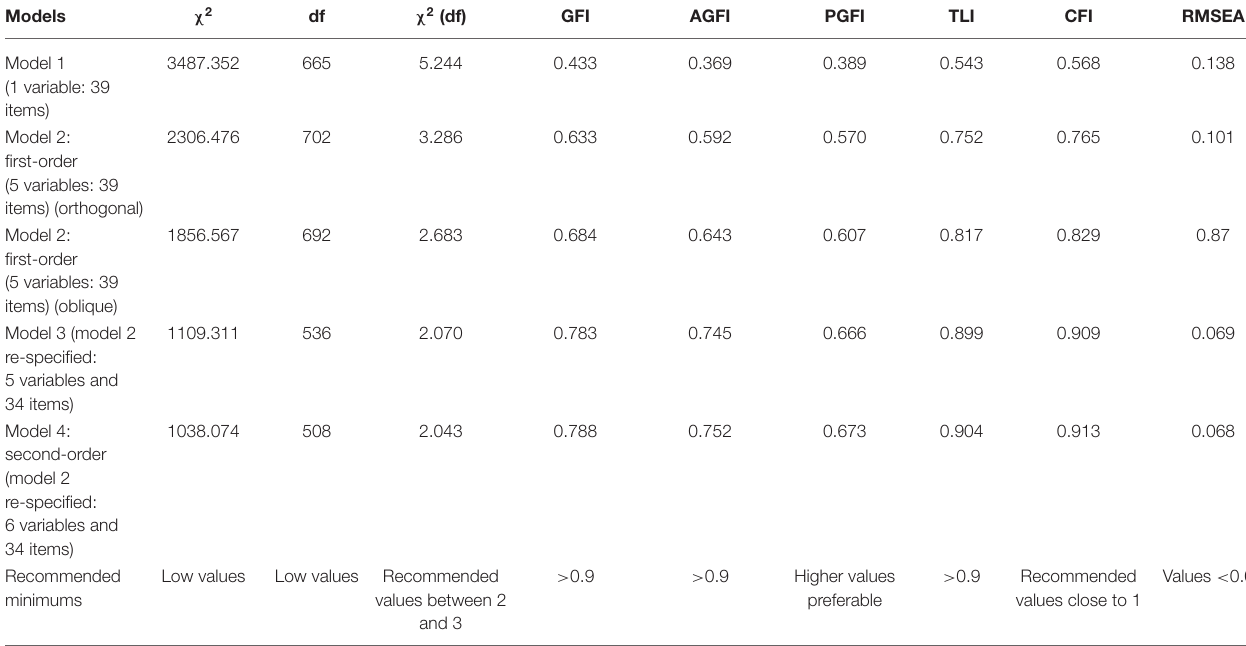
TABLE 2 | Fit indices for quality perceived